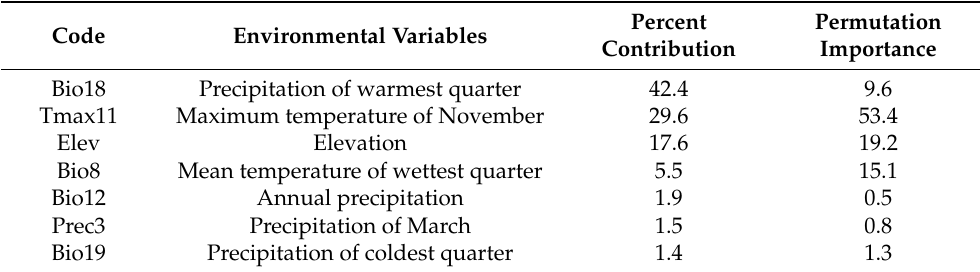
Table 1. Percent contribution and permutation importance of the environmental variables in the MaxEnt model.